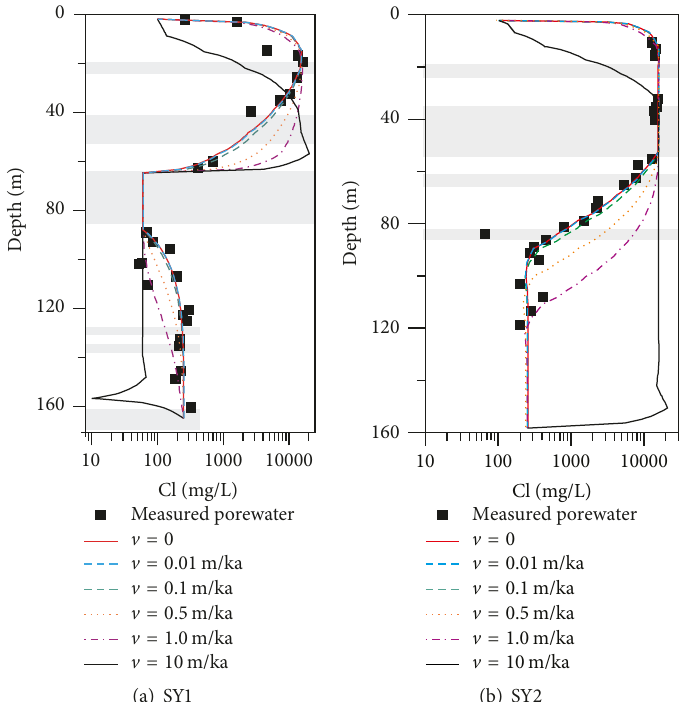
Figure 10: Porewater Cl − measurements of (a) SY1 and (b) SY2 profiles, and simulations with the different groundwater velocities for the two studied